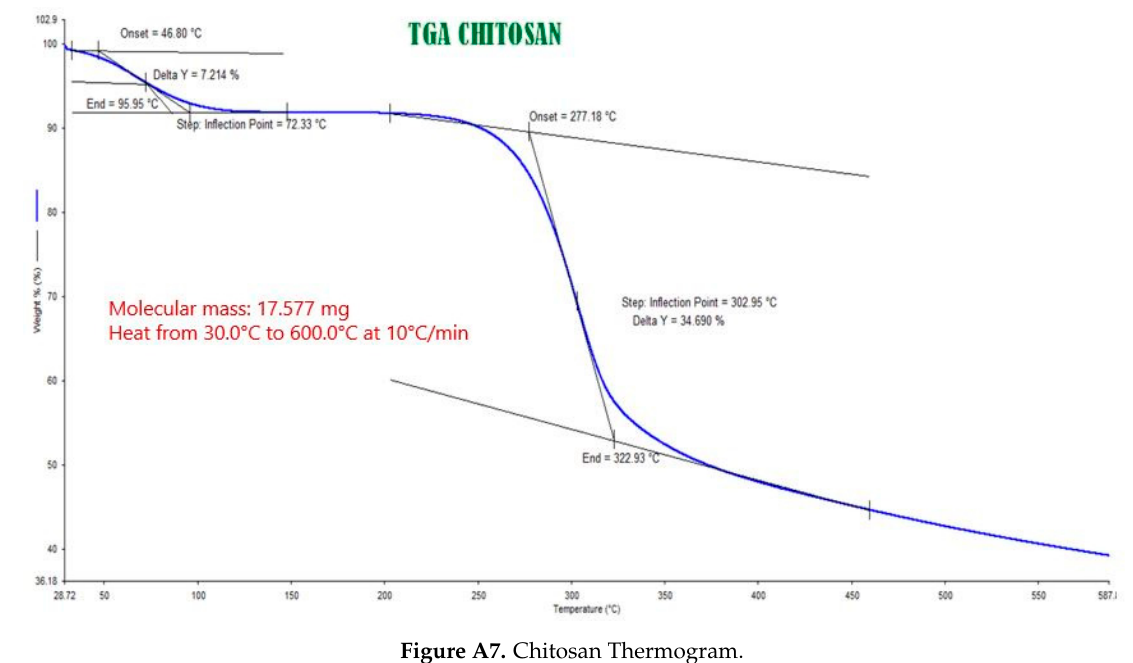
Figure A7. Chitosan Thermogram.